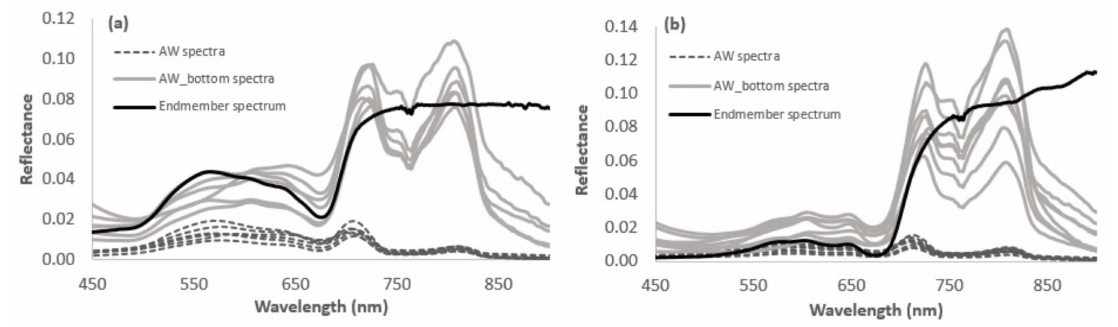
Figure 4. Comparison of above water surface measured vegetation spectra (AW) with water column corrected (AW_bottom) spectra and corresponding endmember spectrum for ( a ) green macroalgae ( Cladophora glomerata ) and ( b ) brown macroalgae ( Fucus vesiculosus